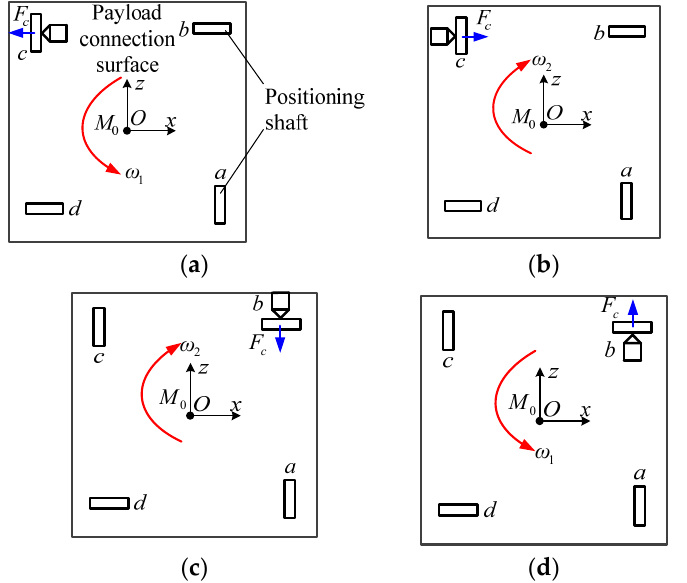
Figure 19. Schematic diagram of the direction of the capture hook and the direction of rotation for the payload. ( a ) Group c capture hooks in the negative x -axis; ( b ) group c capture hooks in the positive x -axis; ( c ) group b capture hooks in the negative z-axis; ( d ) group d capture hooks in the positive z-axis.